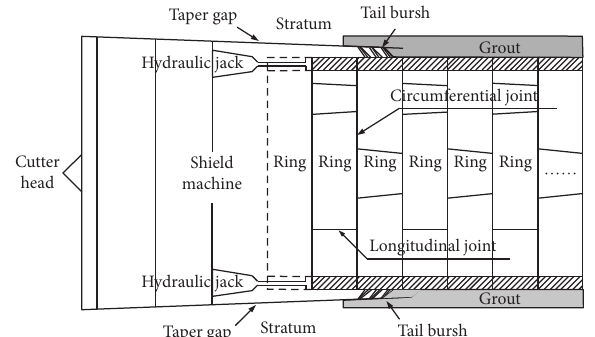
Figure 3: Working condition of shield tunnel during the con- struction